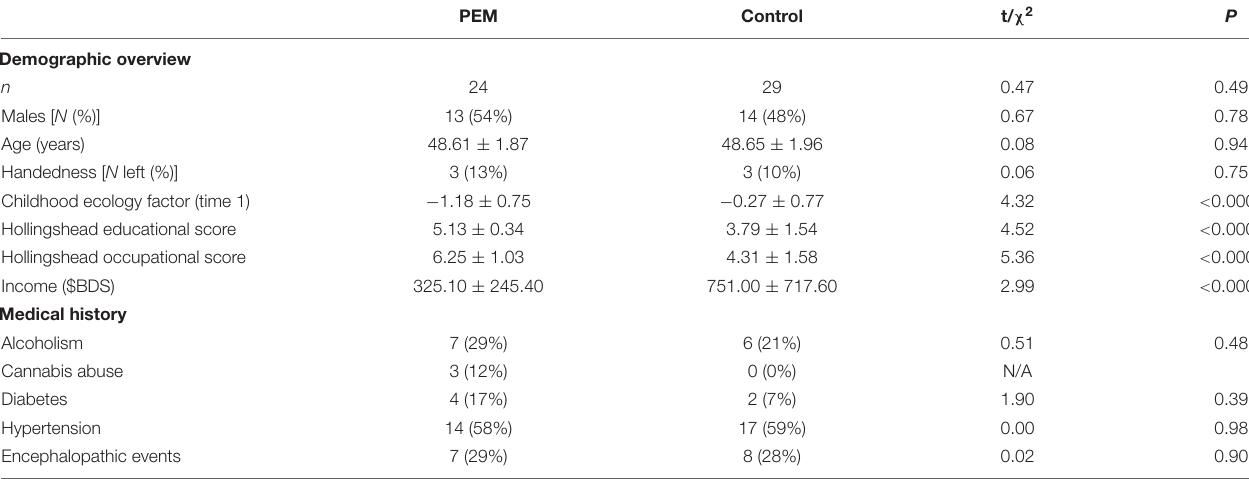
TABLE 1 | Demographic characteristics of participants. PEM Control t/ χ 2 P